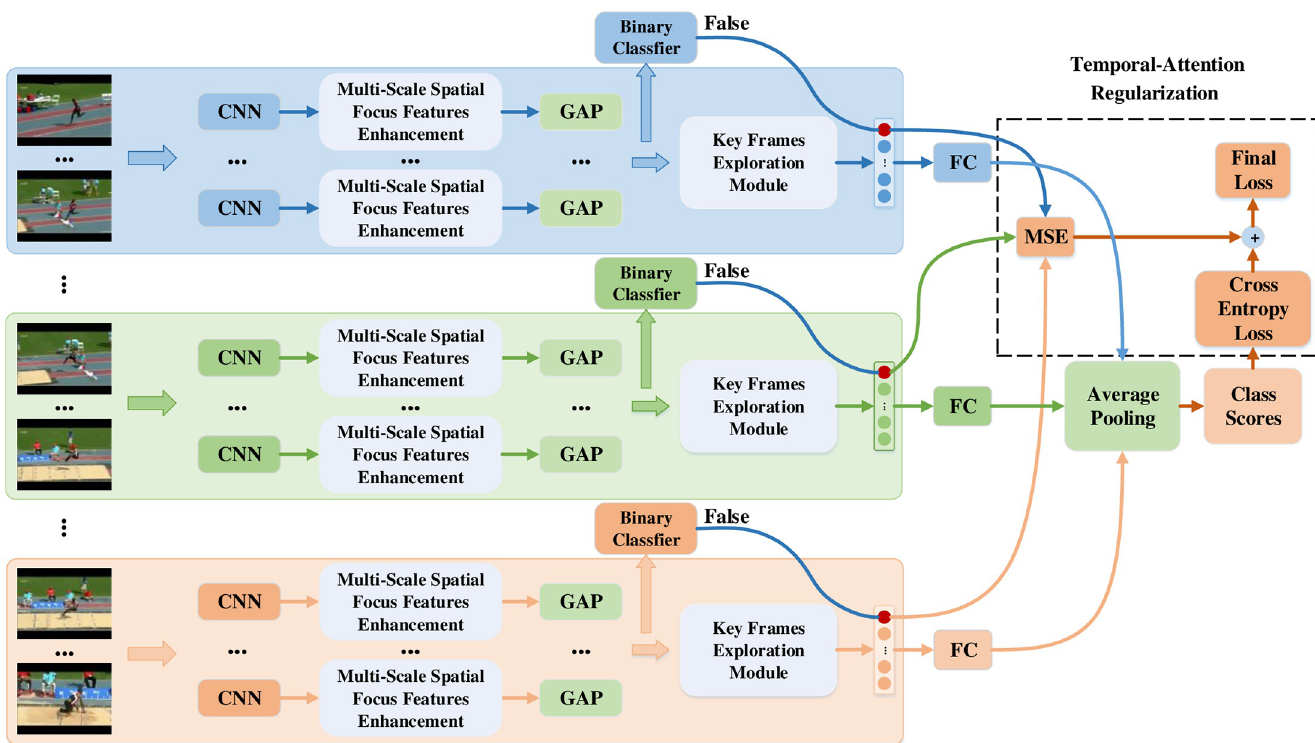
Fig 1. Video-level overview of our STA-TSN. The input video is divided into multiple segments (represented by different colors), and a Multi-Scale Spatial Focus Features Enhancement strategy is used to obtain the global feature presentment with spatial focus features enhancement. Then, the key frames exploration is realized using LSTM and a temporal-attention regularization is designed to guide our model to better explore the key frames. Eventually, the final class score is obtained by fusing the scores of all segments. Meanwhile, the same process is adopted for different modalities. Reprinted from [10] under a CC BY license, with permission from IEEE publisher, original copyright